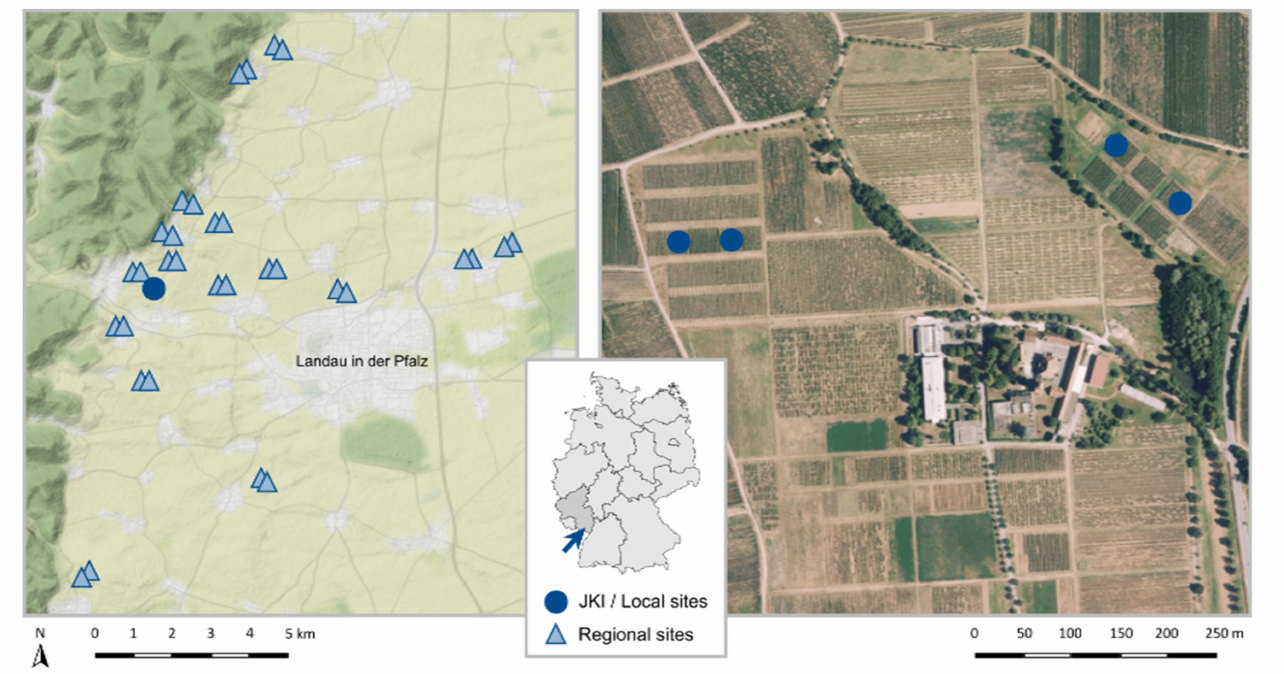
Figure 1. Study area with the location of the Julius Kühn institute (JKI) and the 32 regional sampling sites ( left , map data by OpenStreetMap, under ODbL) and the institutes area with the location of the four local sampling sites ( right , image data by © GeoBasis-DE/LVermGeoRP (2022)). The arrow indicates the study area in Rhineland-Palatinate on the map of